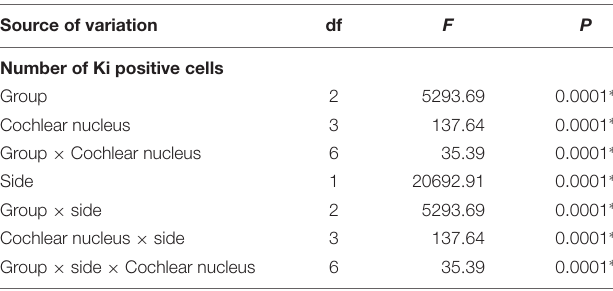
TABLE 2 | Statistical analysis of the effects of UCN on the cell proliferation in the cochlear nuclei complex of adult